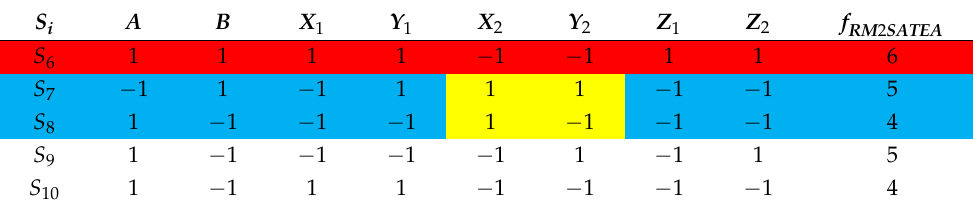
Table A6. S 6 remained as candidate in Party